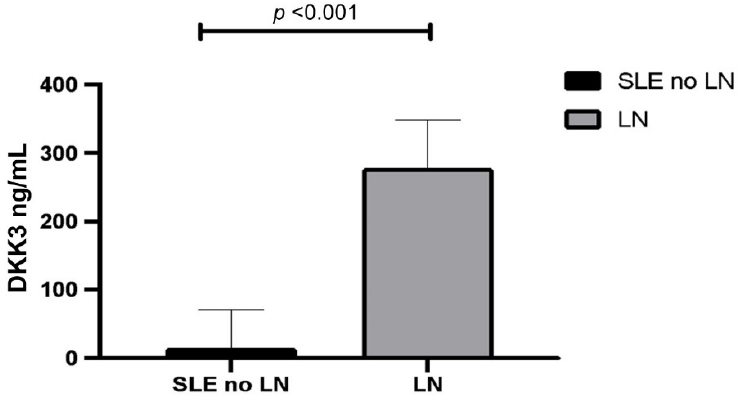
Figure 1. DKK3 levels in SLE with LN vs. SLE with no renal involvement. (SLE = systemic lupus erythematosus; LN = lupus nephritis; DKK3 = Dickkopf-related protein 3). erythematosus; LN = lupus nephritis; DKK3 = Dickkopf-related protein